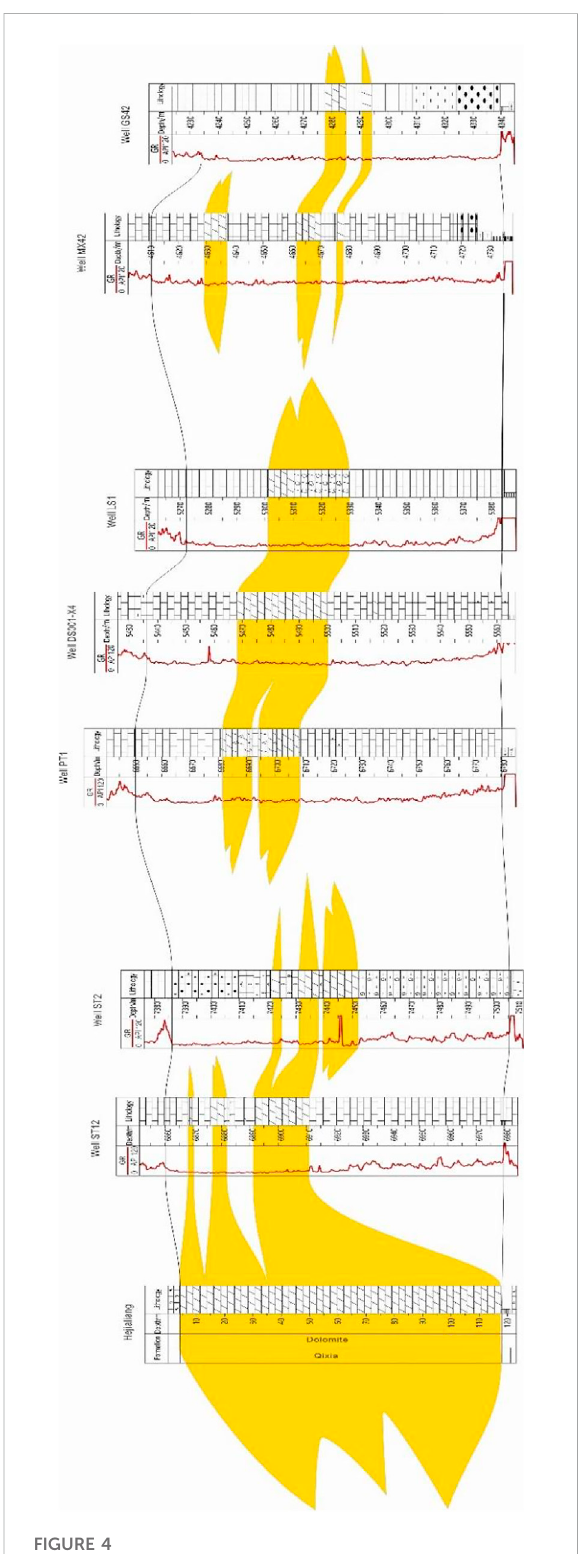
FIGURE 4 Cross section of the Qixia Formation dolomite reservoir (yellow area) in the Sichuan Basin.